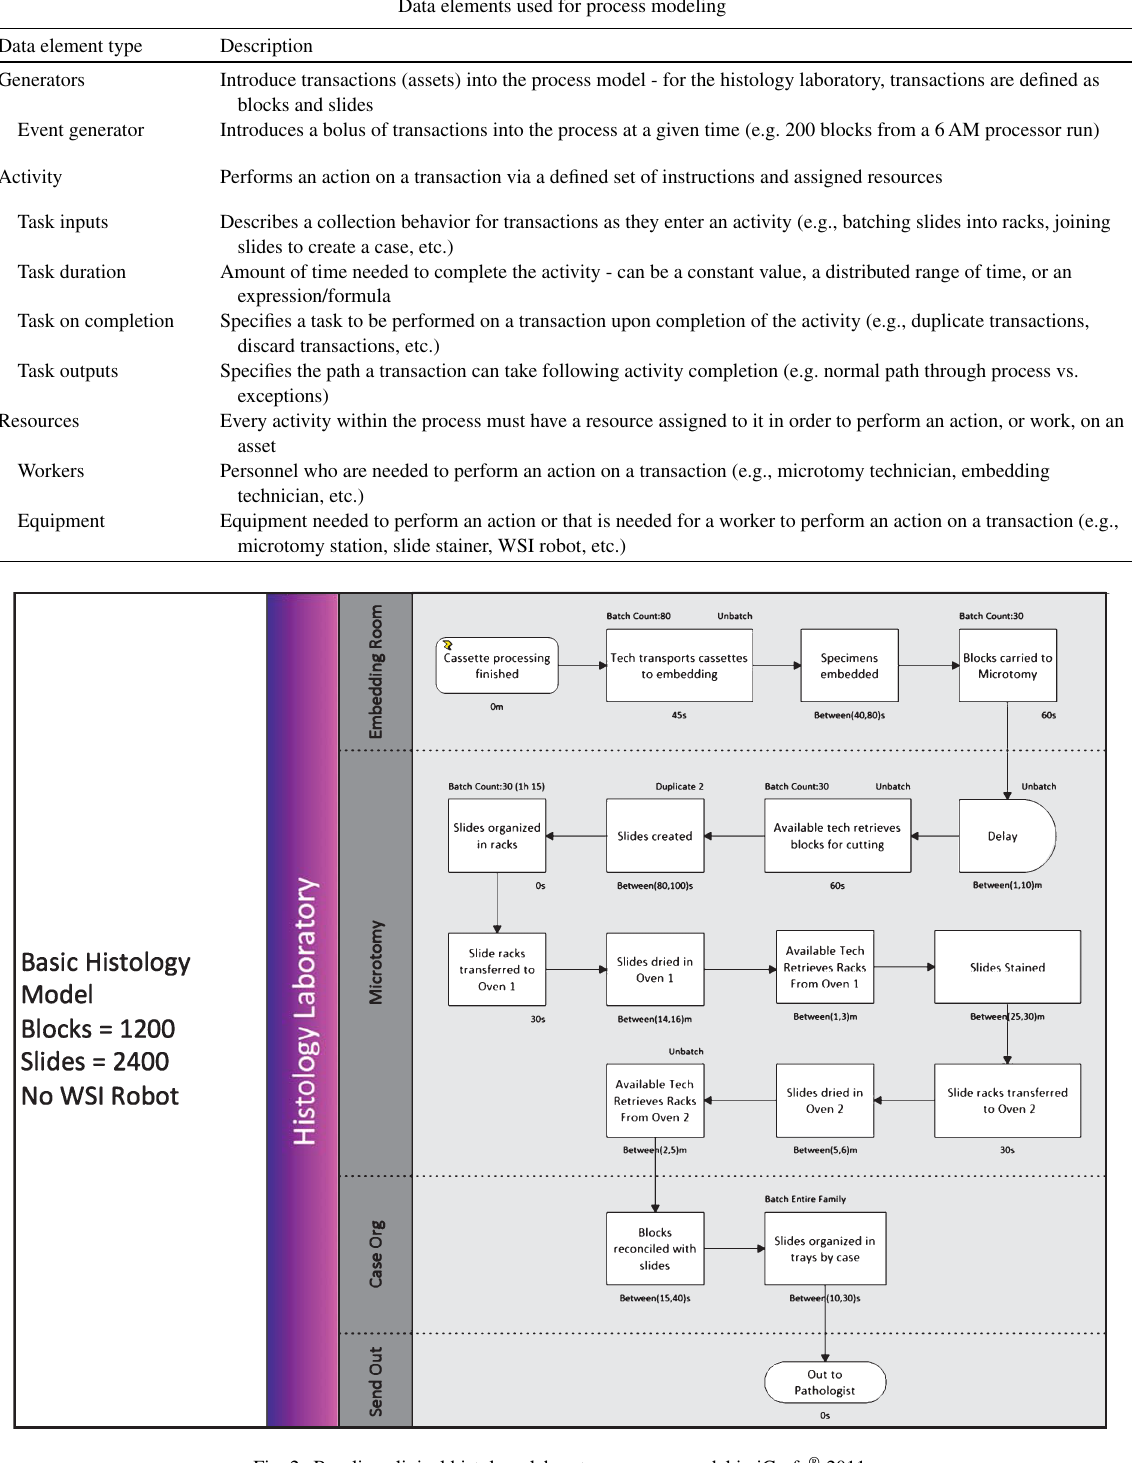
Fig. 2. Baseline clinical histology laboratory process model in iGrafx ®